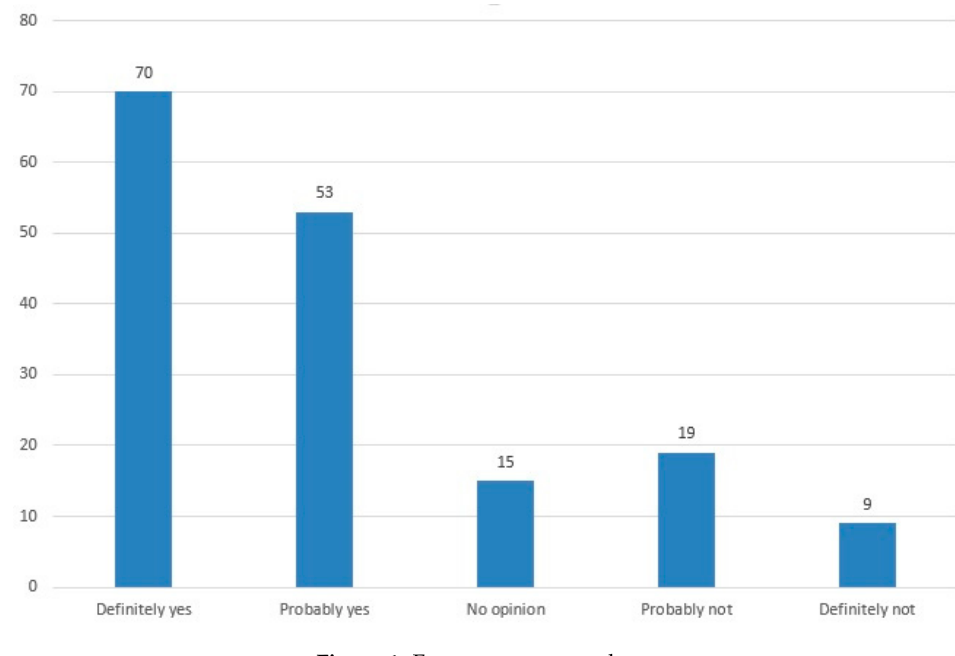
Figure 1. Future pregnancy plans.